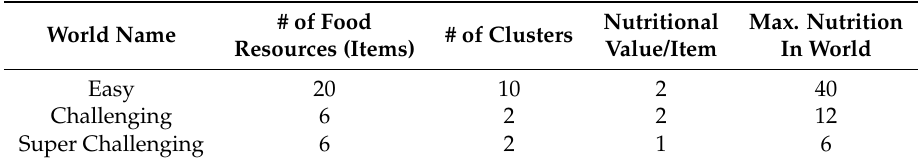
Table 3. Availability of food resources in each of the three world conditions. For a visual representation of these worlds, see Figure 2.